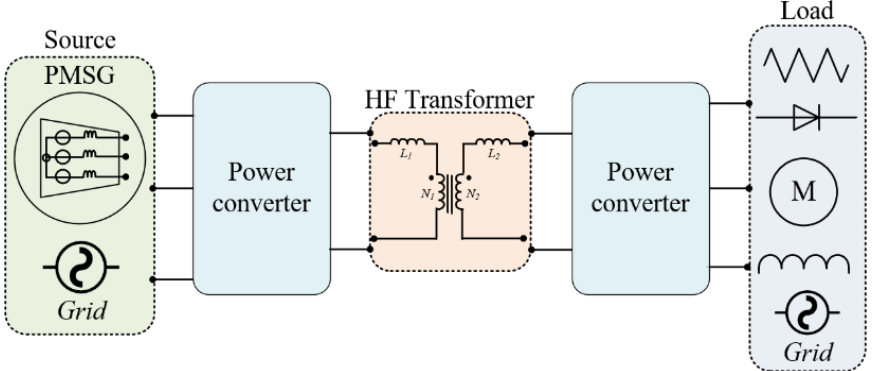
Figure 1. The solid-state transformer concept.